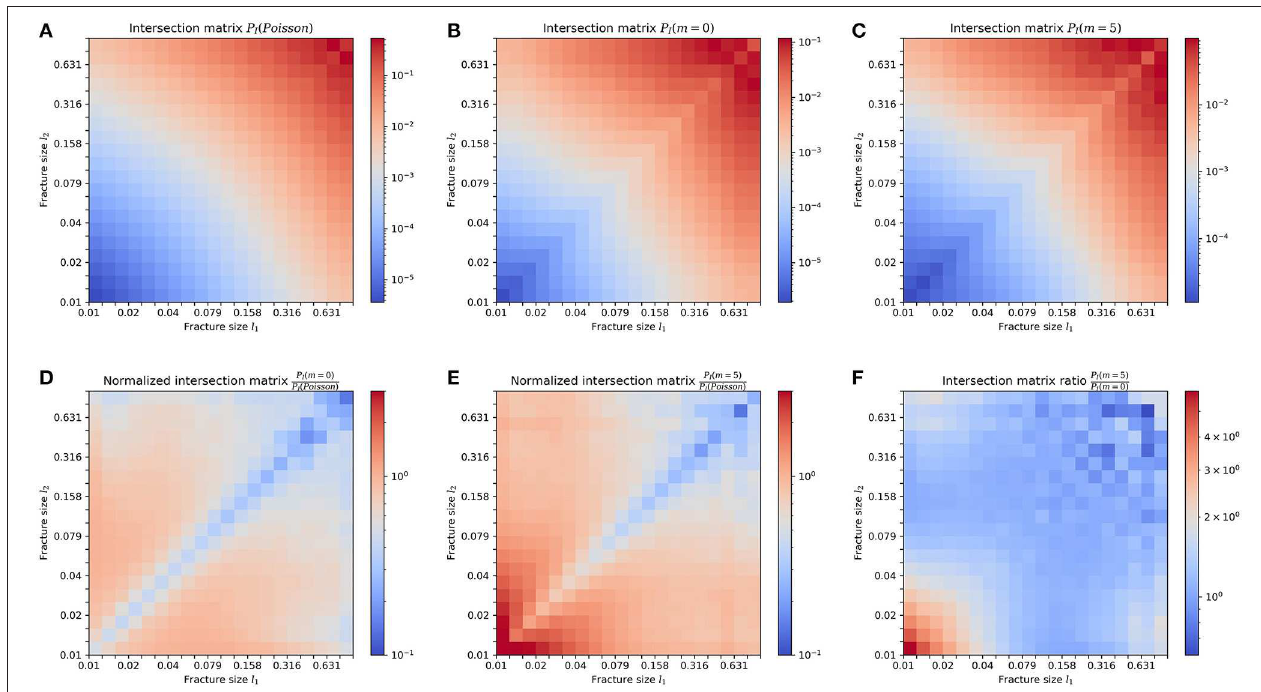
FIGURE 7 | Intersection matrix for (A) Poisson, (B) stress-independent UFM, and (C) stress-driven UFM models. (D) Normalized intersection matrix P I ( m = 0 ) stress-independent UFM models, (E) Normalized intersection matrix P I ( m = 5 )